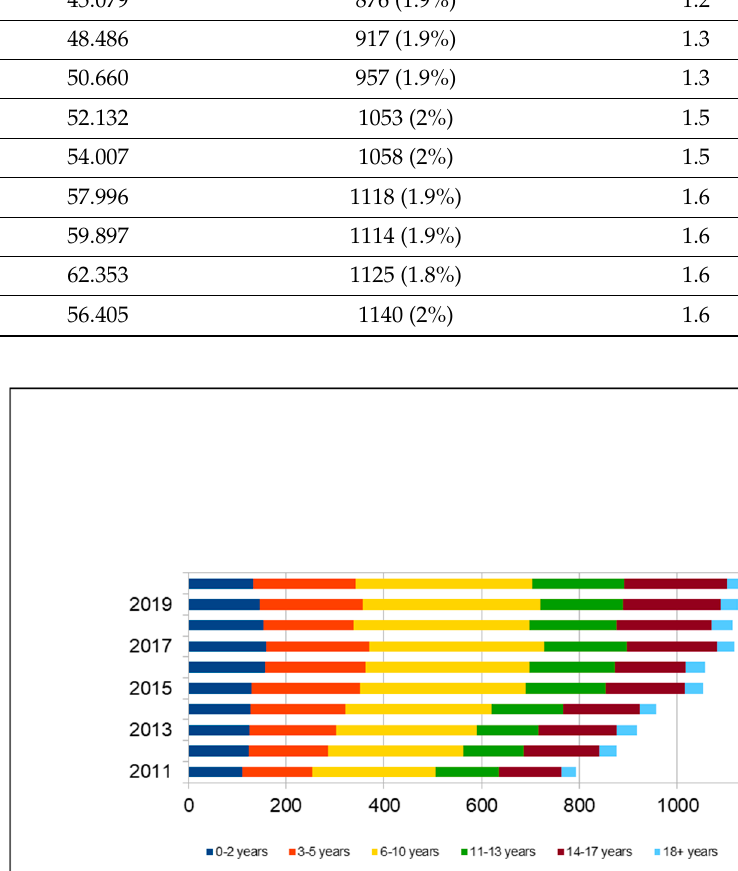
Figure 1. Distribution of ICD-10 codes H90-H91 by age group.